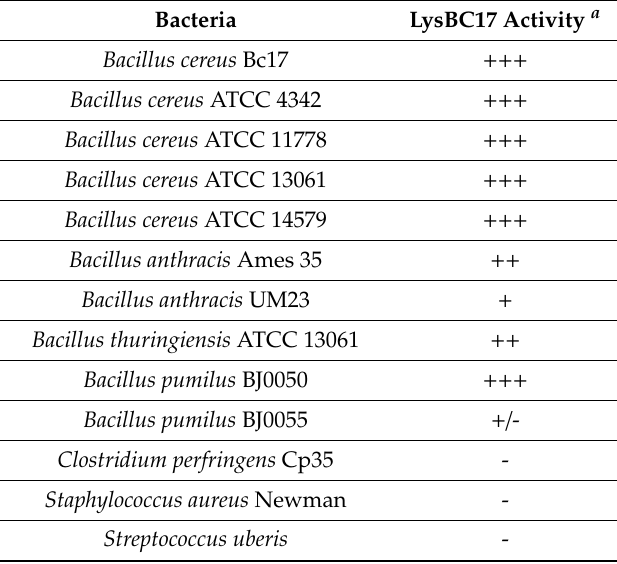
Table 1. Bacterial spectrum of LysBC17 lytic activity. Bacteria LysBC17 Activity